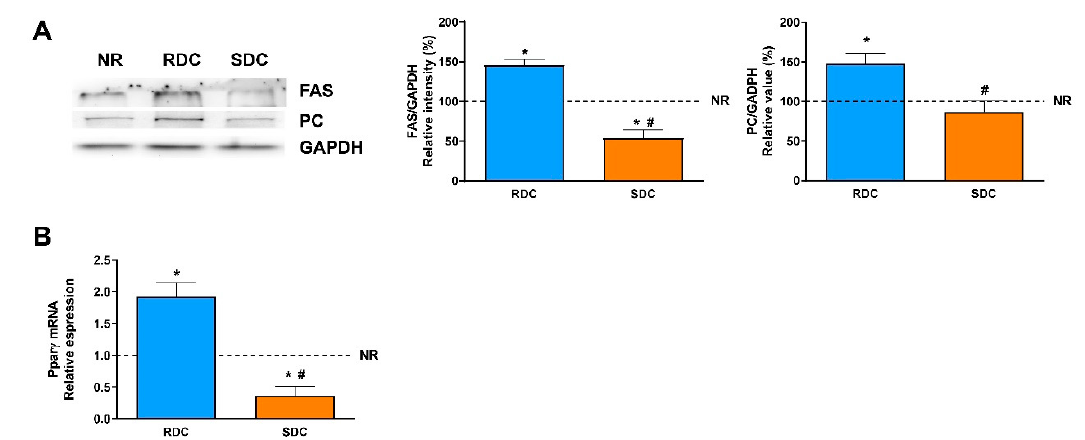
Figure 4. Lipogenesis in adipose tissue of the di ff erent experimental groups. ( A ) The expression of two lipogenic enzymes was assayed by western blot. ( B ) The expression of mRNA levels corresponding to Peroxisome proliferator-activated receptor (Ppar γ ) was assayed by qPCR as described in the methods section. NR group, not restricted; RDC group, re-feeding with rapid digestible CHO diet; SDC group, re-feeding with slow digestible CHO diet. * Significant di ff erence with NR group, p < 0.05. # Significant di ff erence with RDC group, p <